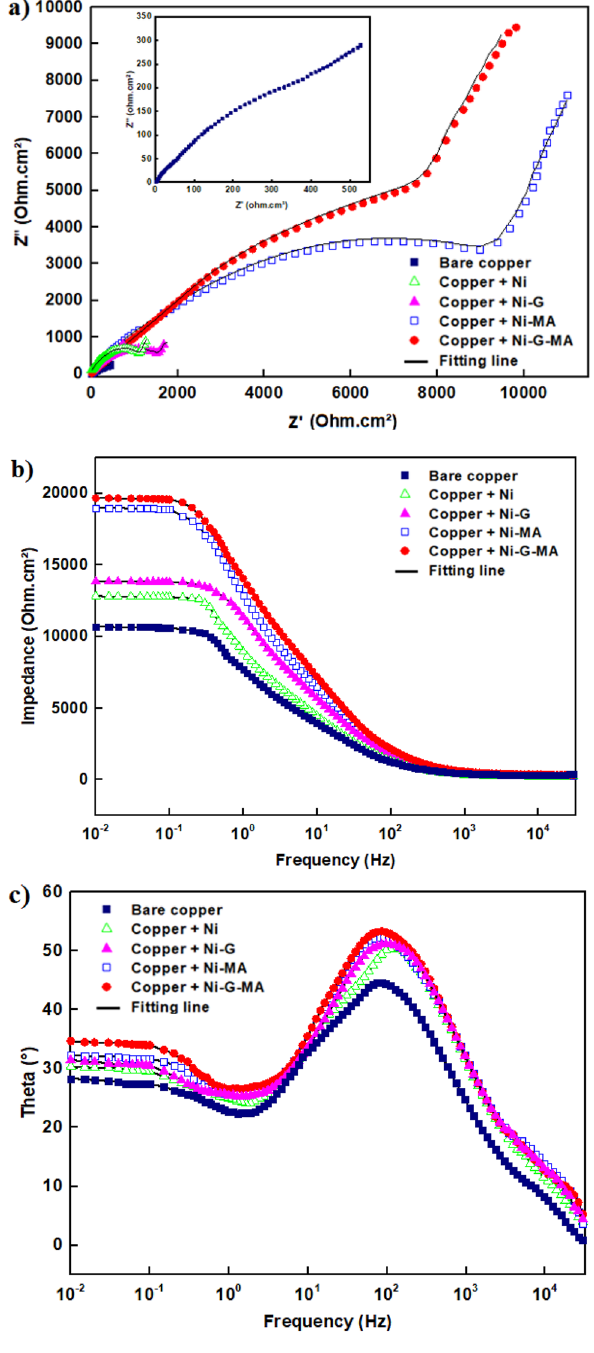
Figure 9. Nyquist and Bode plots of the bare and coated copper with Ni, Ni-G, Ni-MA, and Ni-G-MA in 0.5 M NaCl